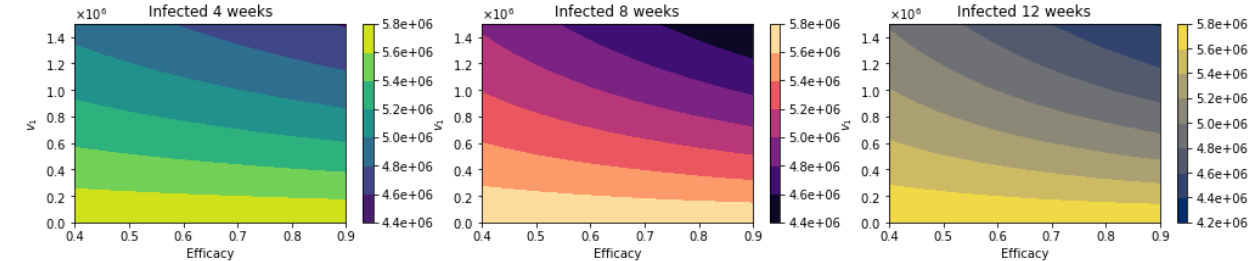
Figure 14. Total number of infected people for a variety of vaccine efficacies after the first dose and different vaccination rates per day. The basic reproduction number R 0 > 1. Assuming that the asymptomatic and presymptomatic individuals have just 25% of infectiousness relative to symptomatic people [113].